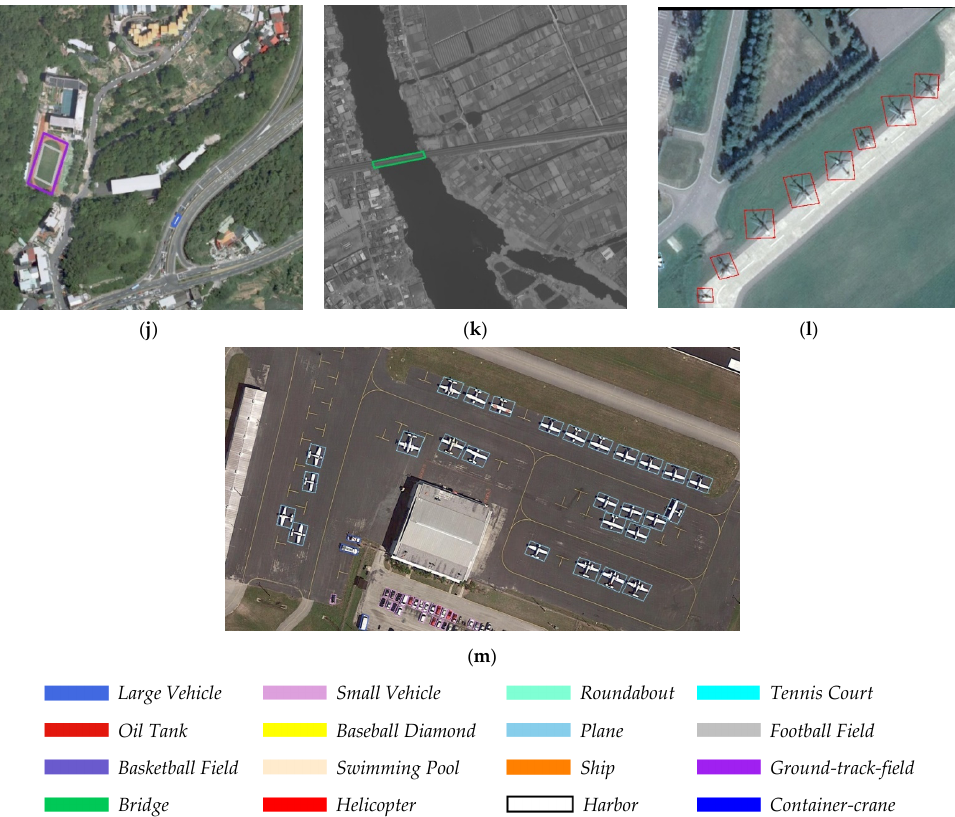
Figure 10. Some visual results of detection with TPR-R2CNN (double head with classification fusion) network (the threshold score is 0.5) for the DOTA-v1.5 dataset: ( a ) large vehicle, small vehicle; ( b ) roundabout, small vehicle; ( c ) tennis court, small vehicle; ( d ) oil tank, ship, and small vehicle; ( e ) plane, large vehicle, and small vehicle; ( f ) ship, small vehicle; ( g ) football field, tennis court, small vehicle, baseball diamond, basketball field, and swimming pool; ( h ) harbor; ( i ) baseball diamond; ( j ) football field, ground-track-field, and large vehicle; ( k ) bridge; ( l ) helicopter; and ( m ) plane, large vehicle, and small vehicle.